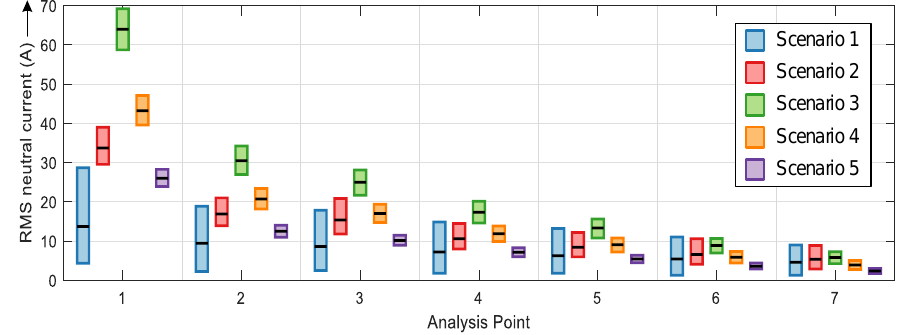
Figure 5. Neutral current RMS values for all scenarios under sinusoidal supply voltage.